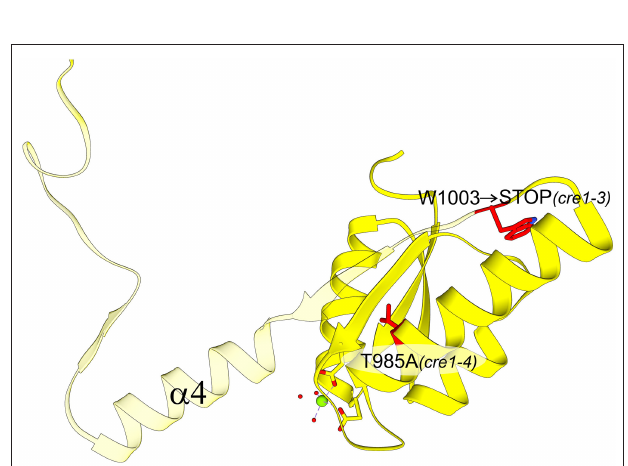
FIGURE 7 | AtCRE1-REC with two mutation variants (residues marked in red): cre1-3 and cre1-4 . The view is rotated 180 ◦ around the y-axis with respect to Figure 5A . The cre1-4 variant has a single amino acid substitution while the cre1-3 mutation leads to a stop codon at Trp1003. The protein product of cre1-3 is truncated (transparent fragment), losing its 3D swapping subdomain and displaying abnormal